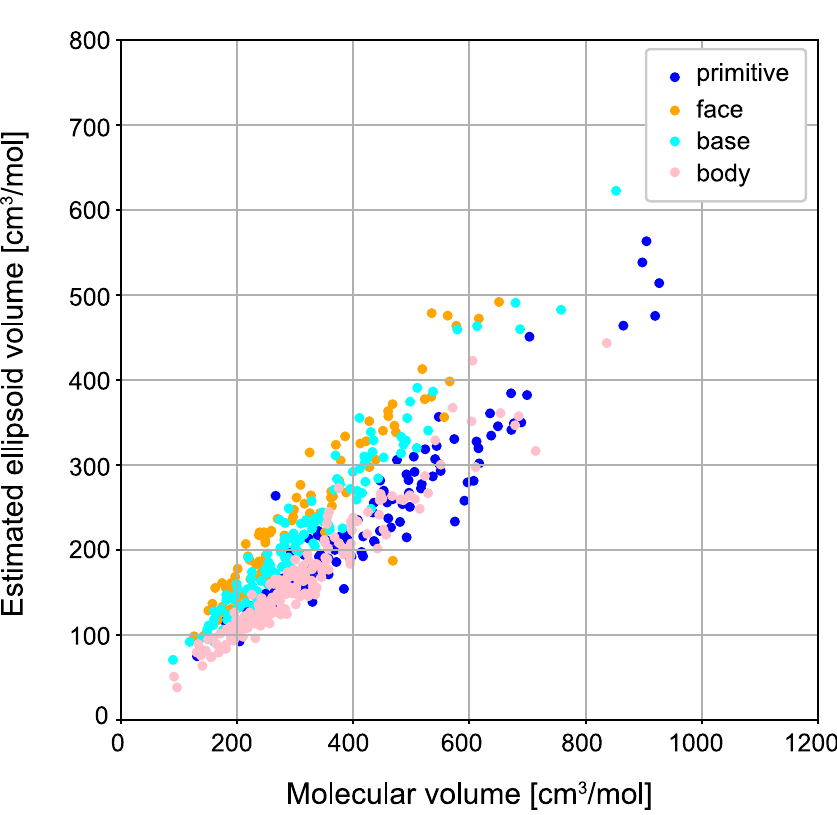
Fig 8. Correlation between the estimated ellipsoid volume and the molecular volume. The ellipsoid volume [cm 3 / mol] (the vertical axis) was calculated from the estimated radii. The molecular volume [cm 3 /mol] (the horizontal axis) was calculated using Gaussian 16 which is a general purpose computational chemistry software [46]. The Pearson’s correlation coefficient for all the points is 0.897.